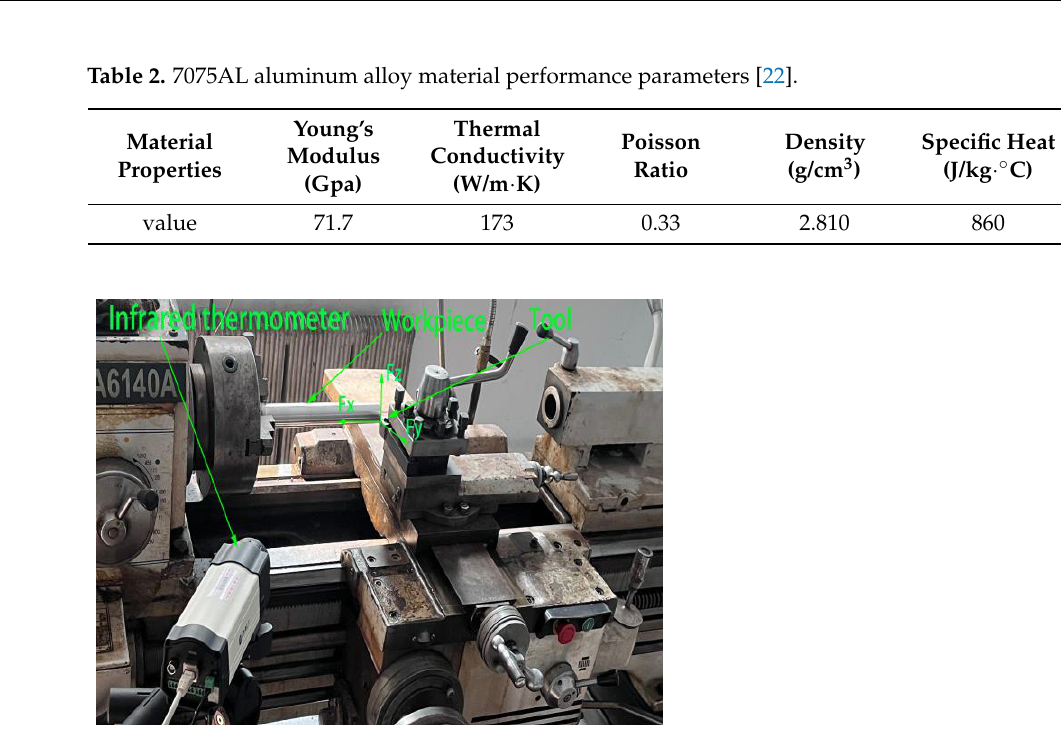
Figure 1. Test equipment diagram.